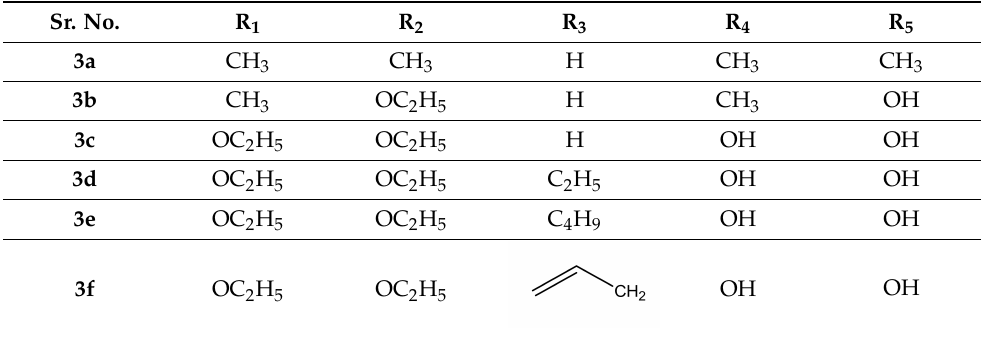
Table 1. Derivatives of 2-aminopyrimidine. Sr.